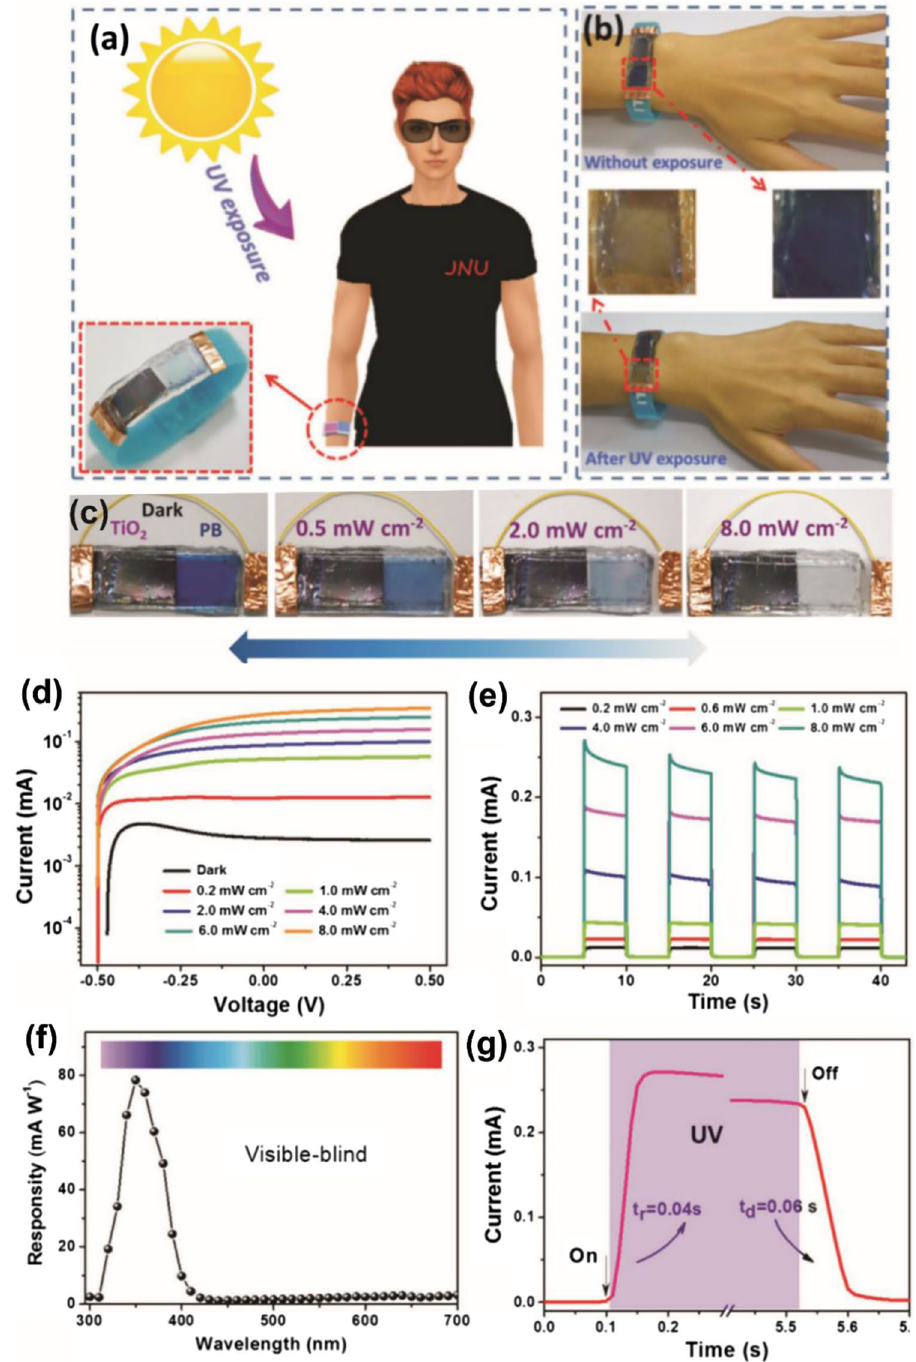
Fig. 9 a , b Application of the flexible and wearable UV photodetector on a wrist, with and without UV exposure, evidencing the color change, together with ( c ) the real images of the flexible device in the dark and exposed to different UV illumination intensities. d Typical I–V curve for the flexible device under dark and UV illumination with various intensities (from 0.2 to 8 mW cm −2 ). e Typical optical switching characteris- tics of the UV photodetector under UV light illumination with varied intensities (0.2–8 mW cm −2 ). f Typical pho- toresponsivity spectrum of the visualized and flexible UV photodetector. g Typical transient photoresponse curves of the flexible UV photodetector (365 nm, 8 mW cm −2 ). Reproduced from [105] with permission of John Wiley and